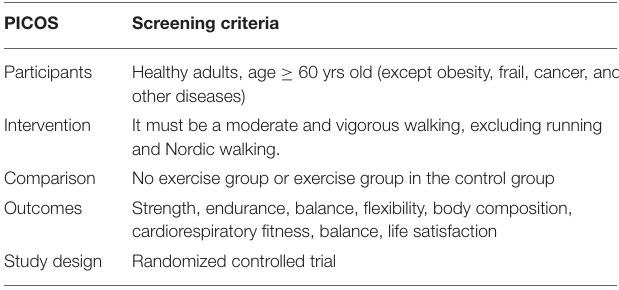
TABLE 1 | Population, intervention, comparator, outcome, and study design (PICOS) detail screening criteria. PICOS Screening